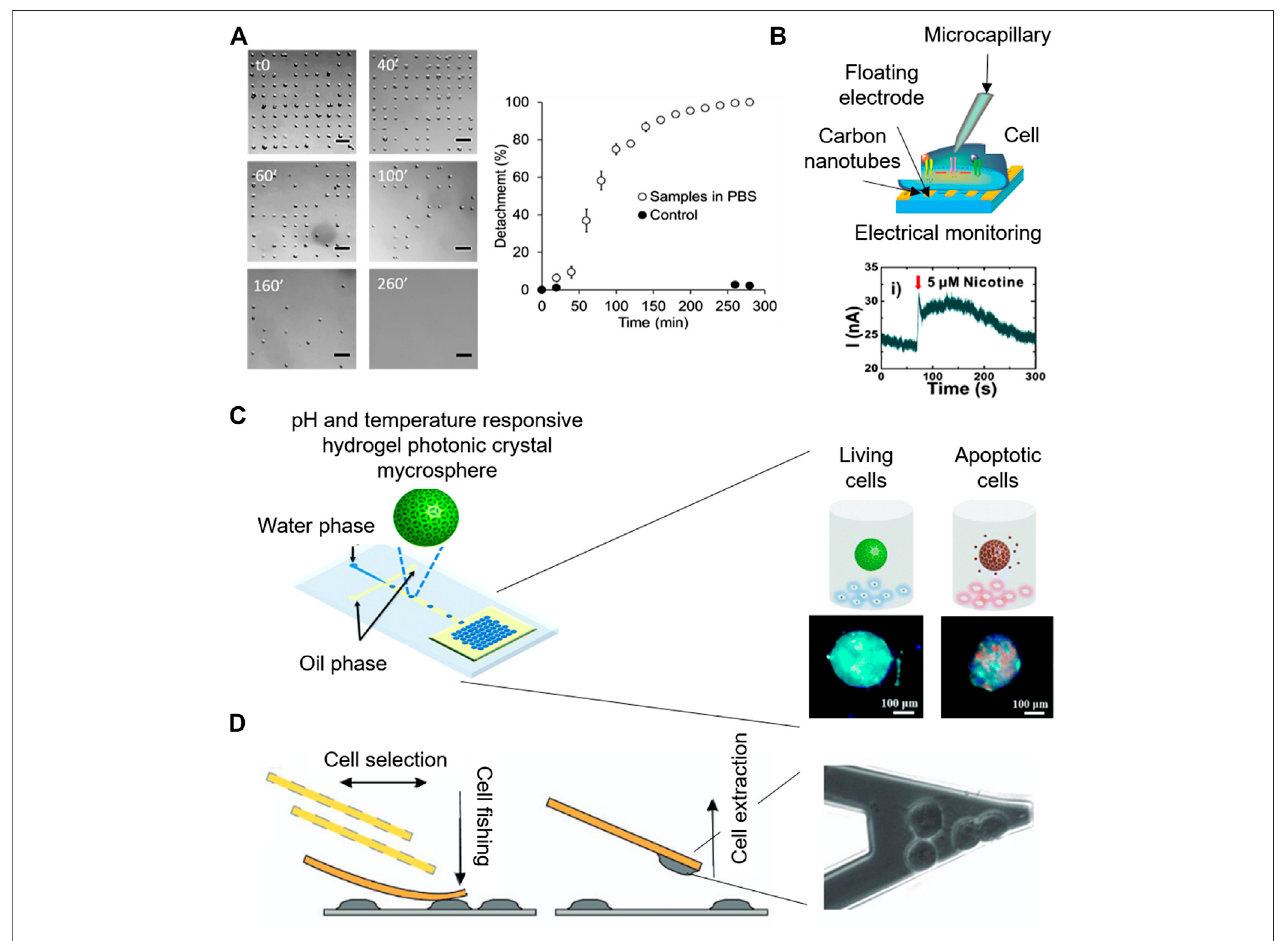
FIGURE 4 | Microsystems for label-free cytotoxicity testing. (A) Quanti fi cation of cell single-cell adhesion for cytotoxicity assessment by optical microscopy. Adapted from (Garcia-Hernando et al., 2020) Copyright © 2020 American Chemical Society. (B) Working principle of the electrophysiological monitoring of cells for cytotoxicity assessment on aligned carbon nanotubes based gold fl oating electrodes Adapted with permission from (Ta et al., 2014) Copyright © 2014 American Chemical Society. (C) Schematic of the Photonic crystal microspheres based cytotoxicity platform, showing the control variation under external stimuli for the detection of cell viability. Adapted from (Wang et al., 2018) with permission from The Royal Society of Chemistry. (D) Cytotoxicity monitoring system based on nanomotion sensing of cellular processes. Adapted with permission from (Ruggeri et al., 2017) Copyright © 2017, Springer Nature.